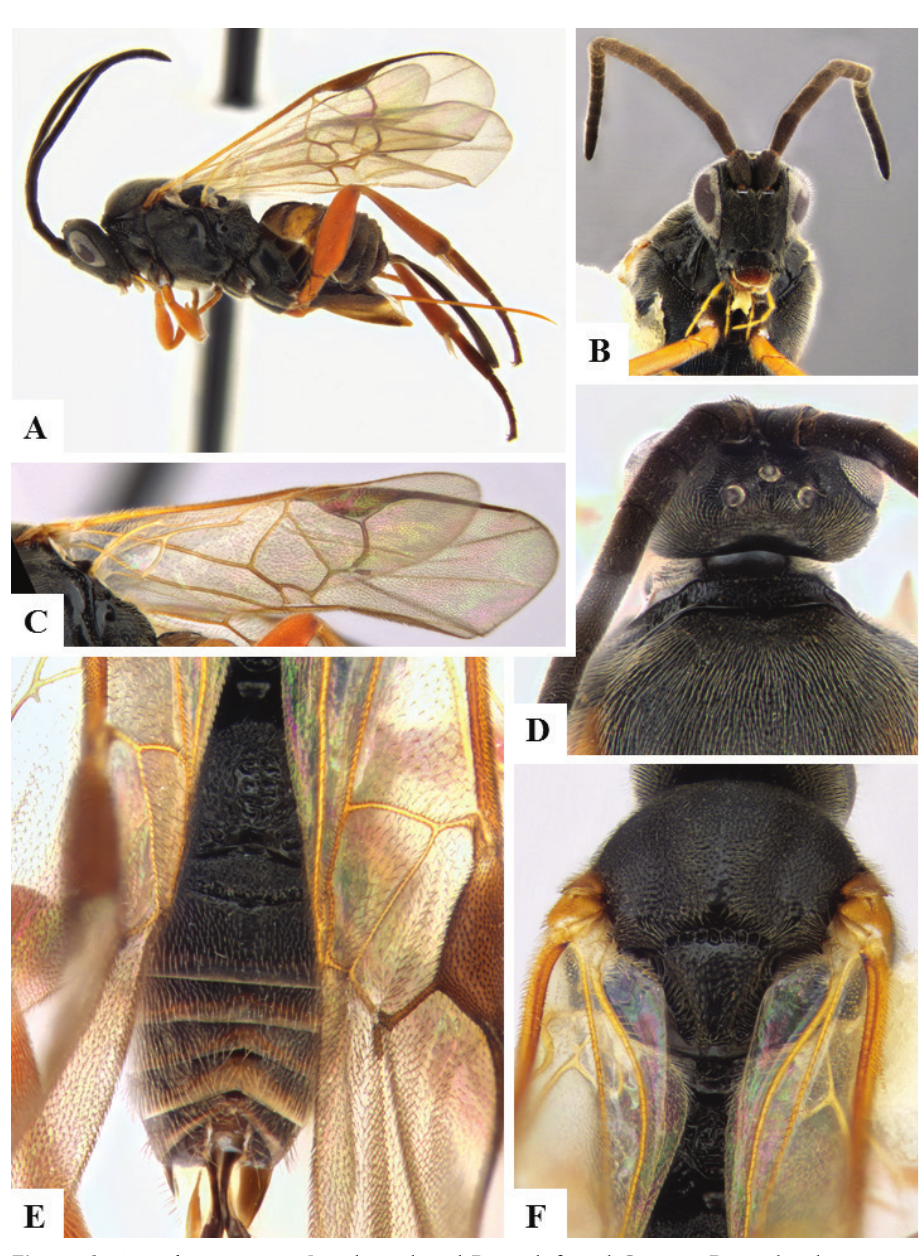
Figure 6. Apanteles crassicornis. A Habitus, lateral B Head, frontal C Wings D Head and mesosoma (partially), dorsal E Metasoma, dorsal F Mesosoma,